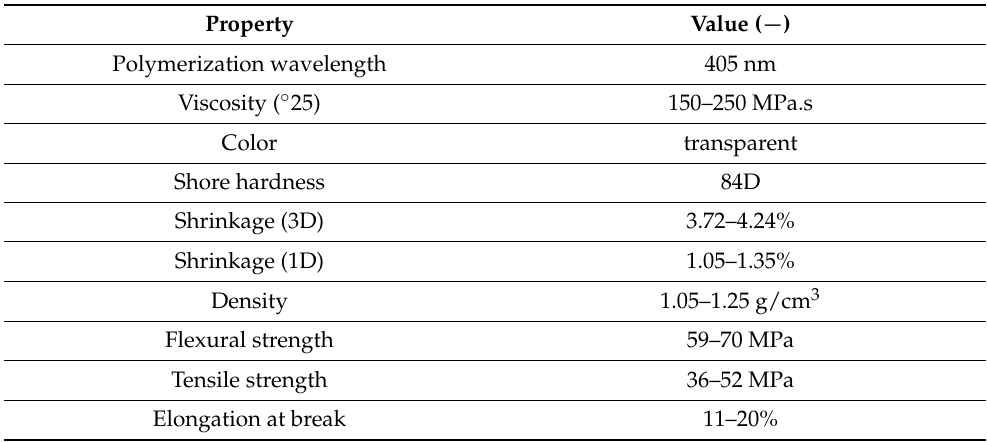
Table 1. Main characteristics of the photosensitive resin.